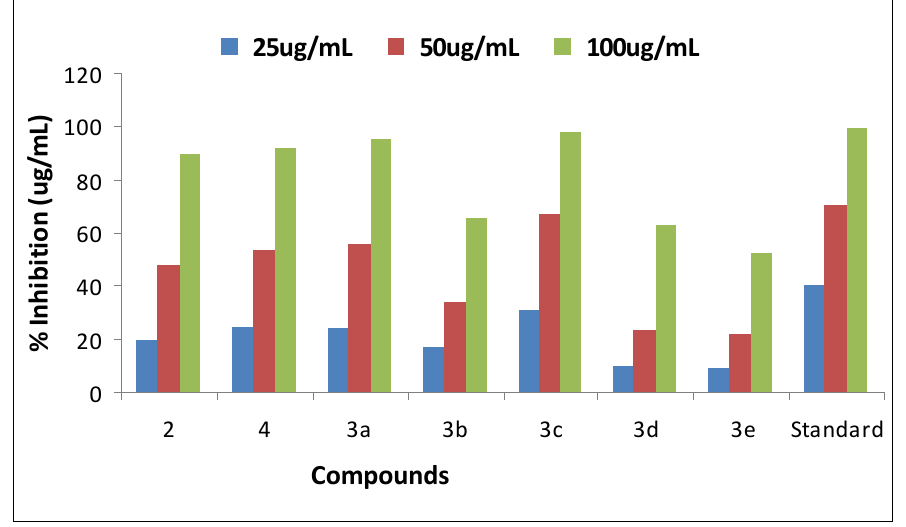
Figure 3. Percent nitric oxide scavenging graph.